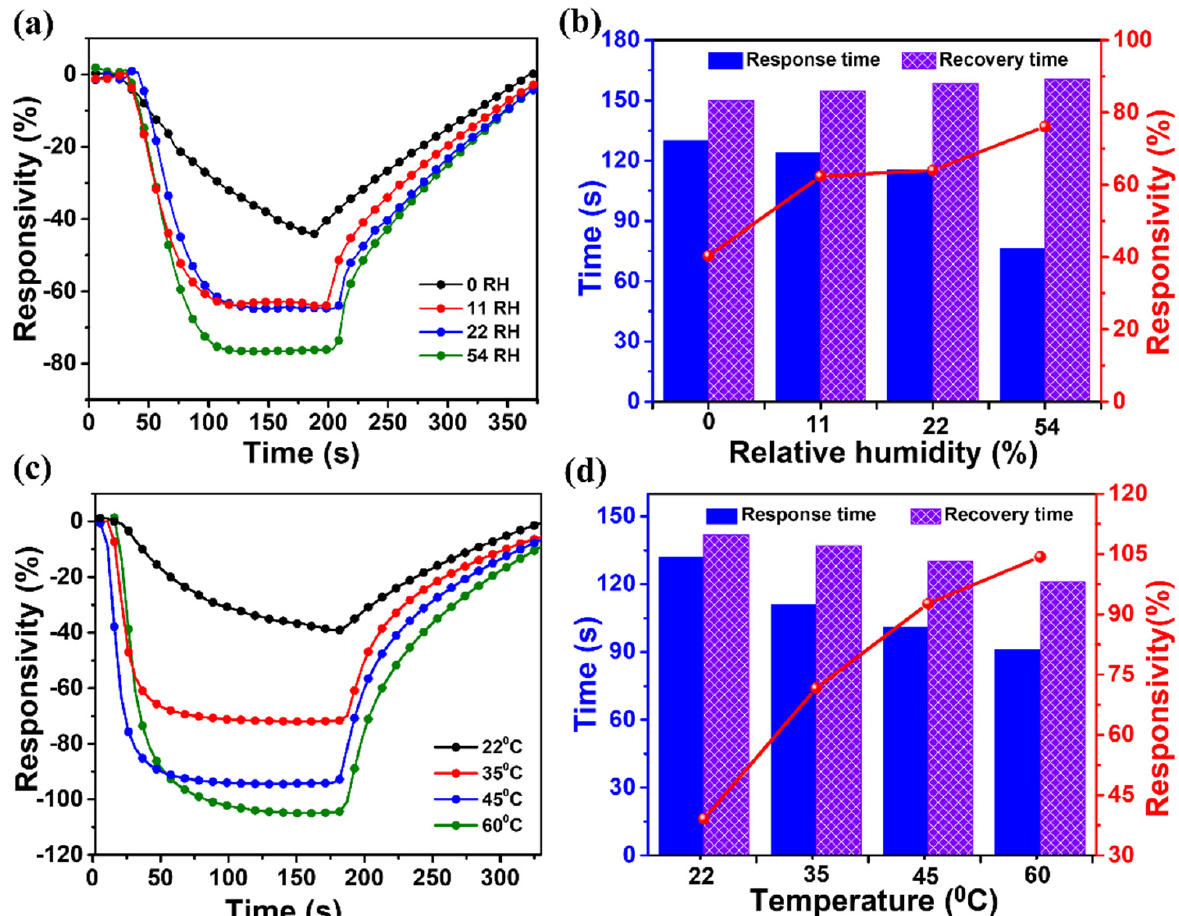
Figure 10. ( a ) Time-dependent responsivity and ( b ) corresponding response/recovery time and responsivity values of the OFET sensors based on P3HT/g-C ₃ N ₄ (90/10) films upon exposure to 10 ppm NO and bare synthetic air under different RHs. ( c ) Time − dependent responsivity and ( d ) cor- responding response/recovery time and responsivity values of the OFET sensors based on the P3HT/g-C ₃ N ₄ (90/10) films at different temperatures (°C).